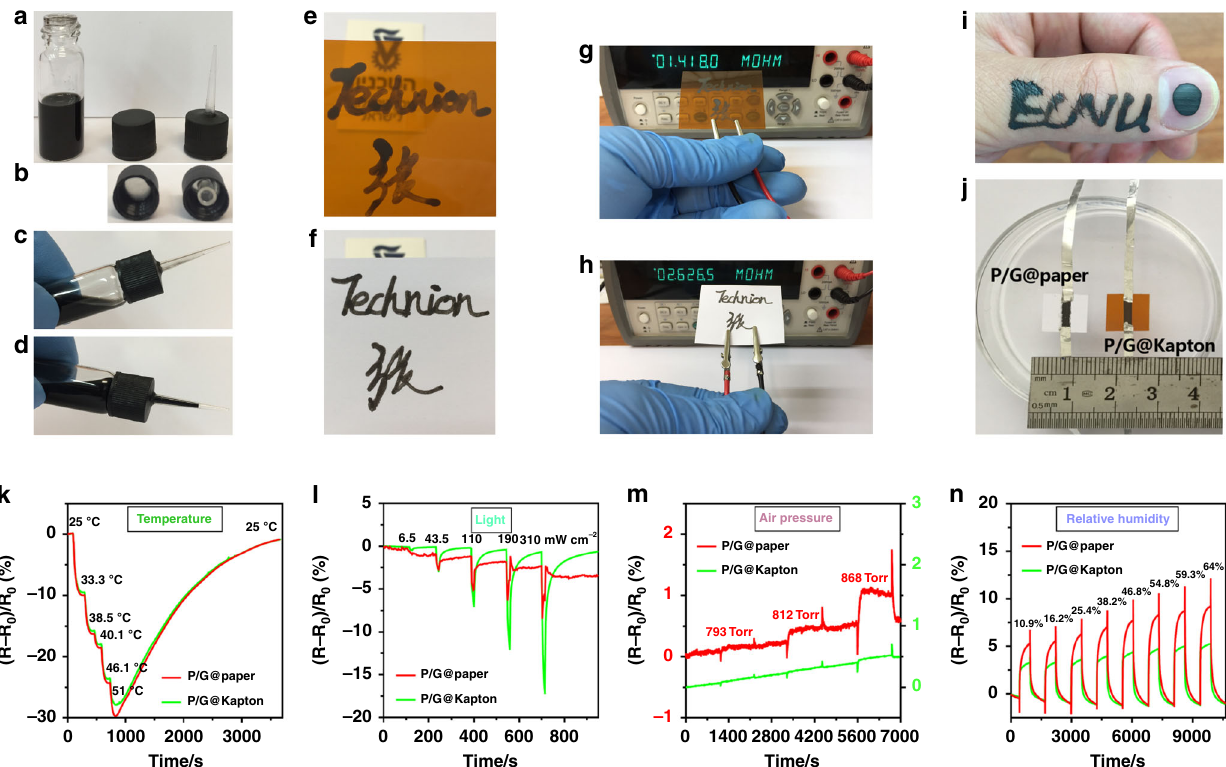
Fig. 1 Formulation of bioinspired conductive ink for writing electronics and sensors. a A vial-based do-it-yourself (DIY) pen loaded with P/G ink. b The DIY pen tip is a 10- μ L pipette microtip punched in a vial cap. c , d P/G ink can controllably fl ow in the DIY pen tip. e – h Conductive texts written on transparent Kapton fi lm and paper. i P/G ink written on skin and fi ngernail as a conductive tattoo. j Image showing the sensors of the P/G@paper and P/G@Kapton. The initial resistance ( R 0 ) of the P/G@paper is 45.3 k Ω and of the P/G@kapton is 77.3 k Ω . k – n Resistance responses of the P/G@paper and P/G@Kapton to temperature (25 – 51 °C), light (6.5 – 310 mW cm − 2 ), air pressure (793 – 868 Torr), and relative humidity (10.6 – 64%). Note: decreases in resistances